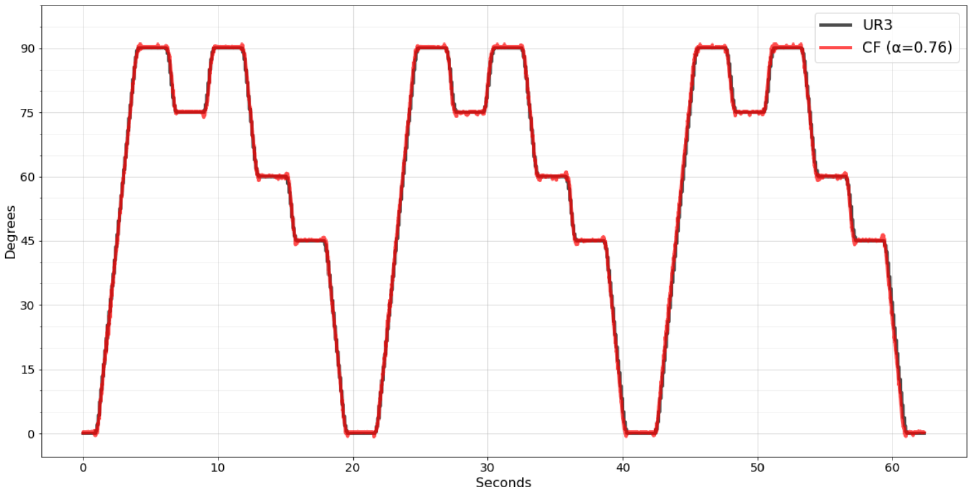
Figure 12. CF filter implemented in wearable embedded